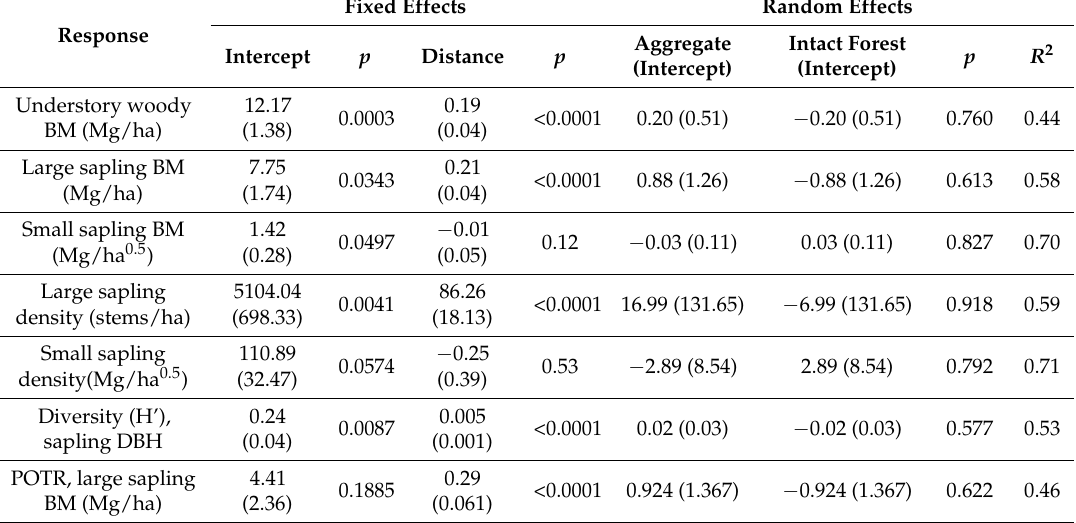
Table B1. Parameter estimates with standard error in parentheses for multilevel models of the effect of distance from harvest edge on forest understory structure. The R 2 provided comes from the regression of observed on predicted values for each model. Abbreviations are as follows: biomass, BM; diameter at breast height, DBH; Populus tremuloides ,